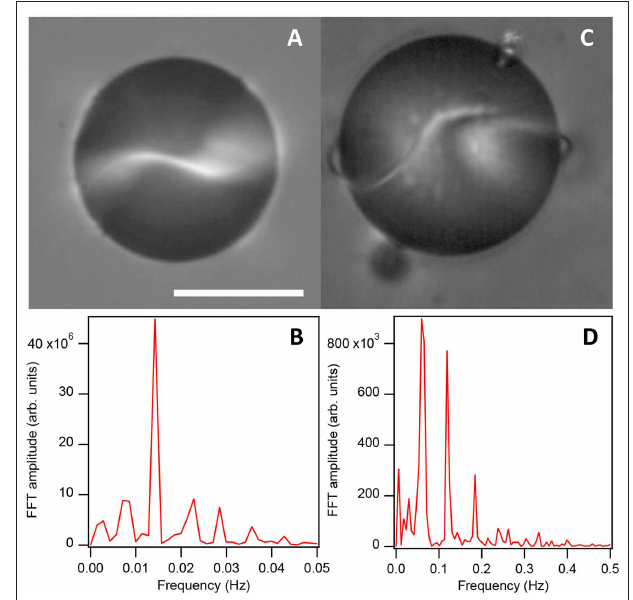
FIGURE 6 | Effect of activity on the SR dynamics. (A) Polarizing micrograph of a single mode oscillating SR driven by an AN shell with [ATP] = 140 µ m, and the corresponding power spectrum of the oscillations (B) . (C) Polarizing micrograph of a multimode oscillating SR driven by an AN shell with [ATP] =